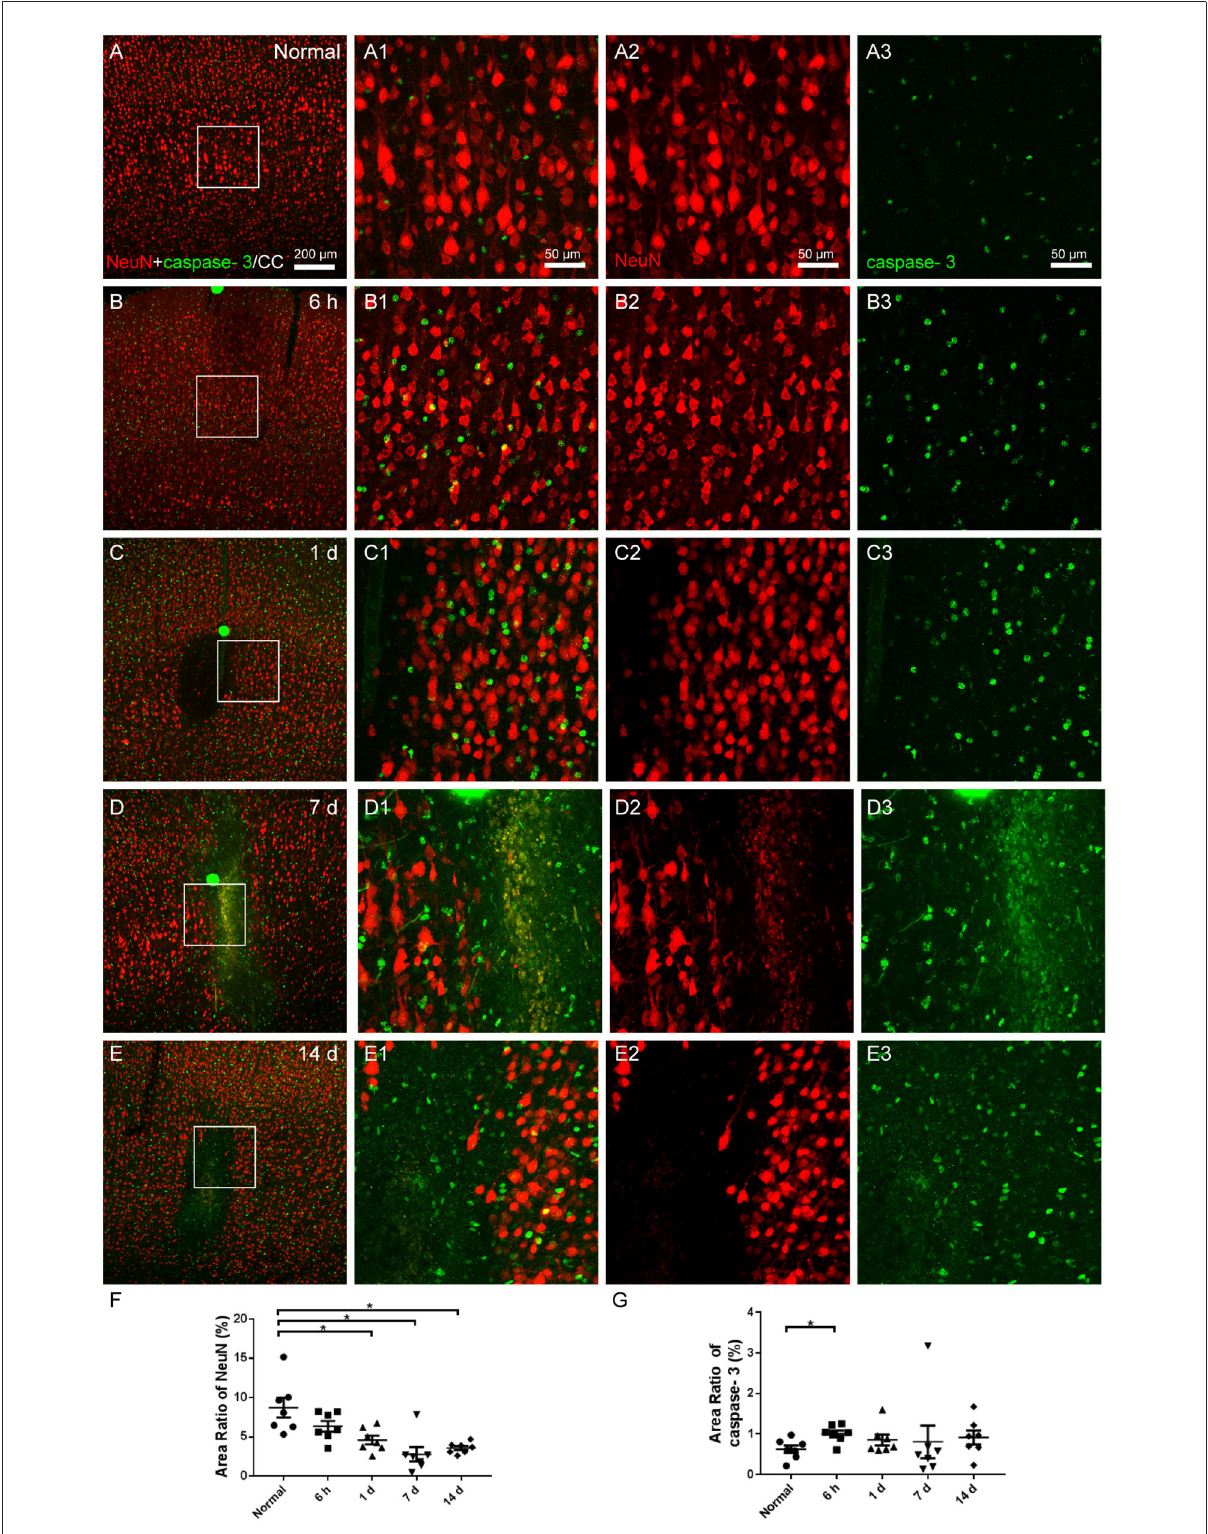
FIGURE7 The neuronal degeneration in the cerebral cortex. (A–E) The representative photographs from the cerebral cortex in groups of normal, 6h, 1, 7, and 14 days, showing the NeuN (red, Alexa Fluor 594)-labeled neurons and cleaved caspase-3 (green, Alexa Fluor 488) labeling.